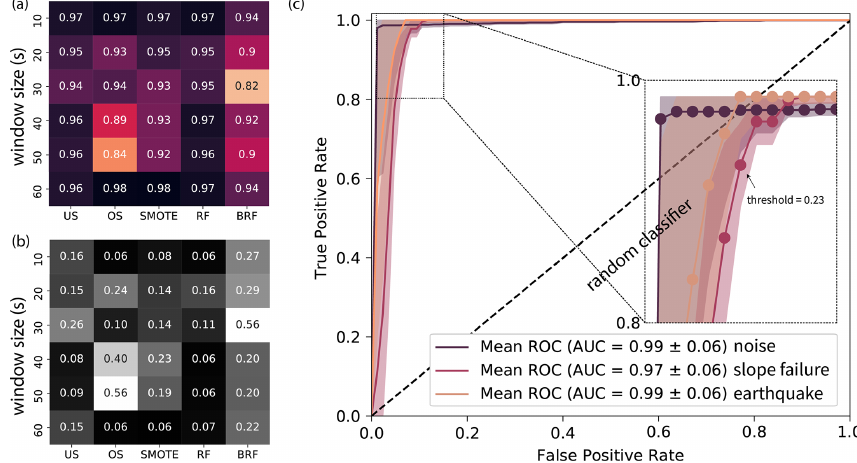
Figure 6. ROC analysis on the Pizzo Cengalo data set. (a) Heatmap of AUC values for SF class for different window sizes and different methods to handle imbalanced data sets, namely undersampling (US), oversampling (OS), synthetic minority oversampling (SMOTE), ran- dom forest with original data set (RF), and balanced random forest (BRF). The darkest colors denote the largest AUC values. (b) Heatmap of 95% confidence interval of AUC values. Darker colors denote smaller standard deviation. (c) ROC curve for 40s time window and random forest. Three-fold cross-validation with mean as solid line and 95% confidence interval. Zoom into corner with circles illustrates TPR and FPR values for different thresholds. Probability threshold for TPR of SF class > 0.9 is